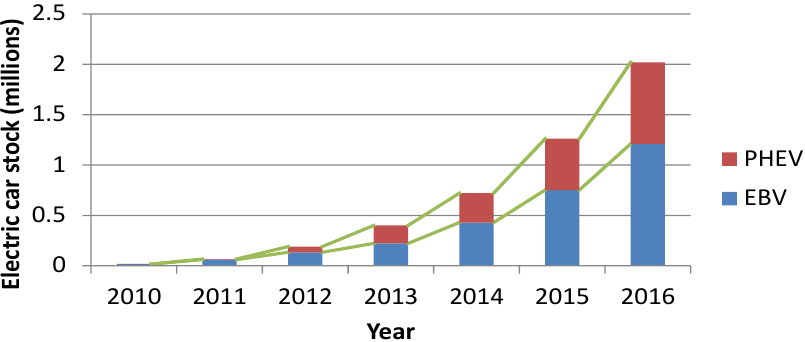
Figure 1. Global stock evolution of electric vehicles (EVs) [1].